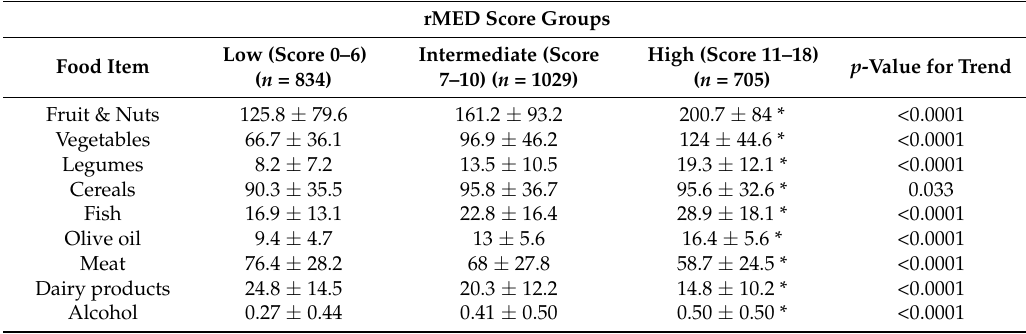
Table 2. Consumption of food groups (expressed as g/1000 kcal/day) by rMED score groups. rMED Score Groups